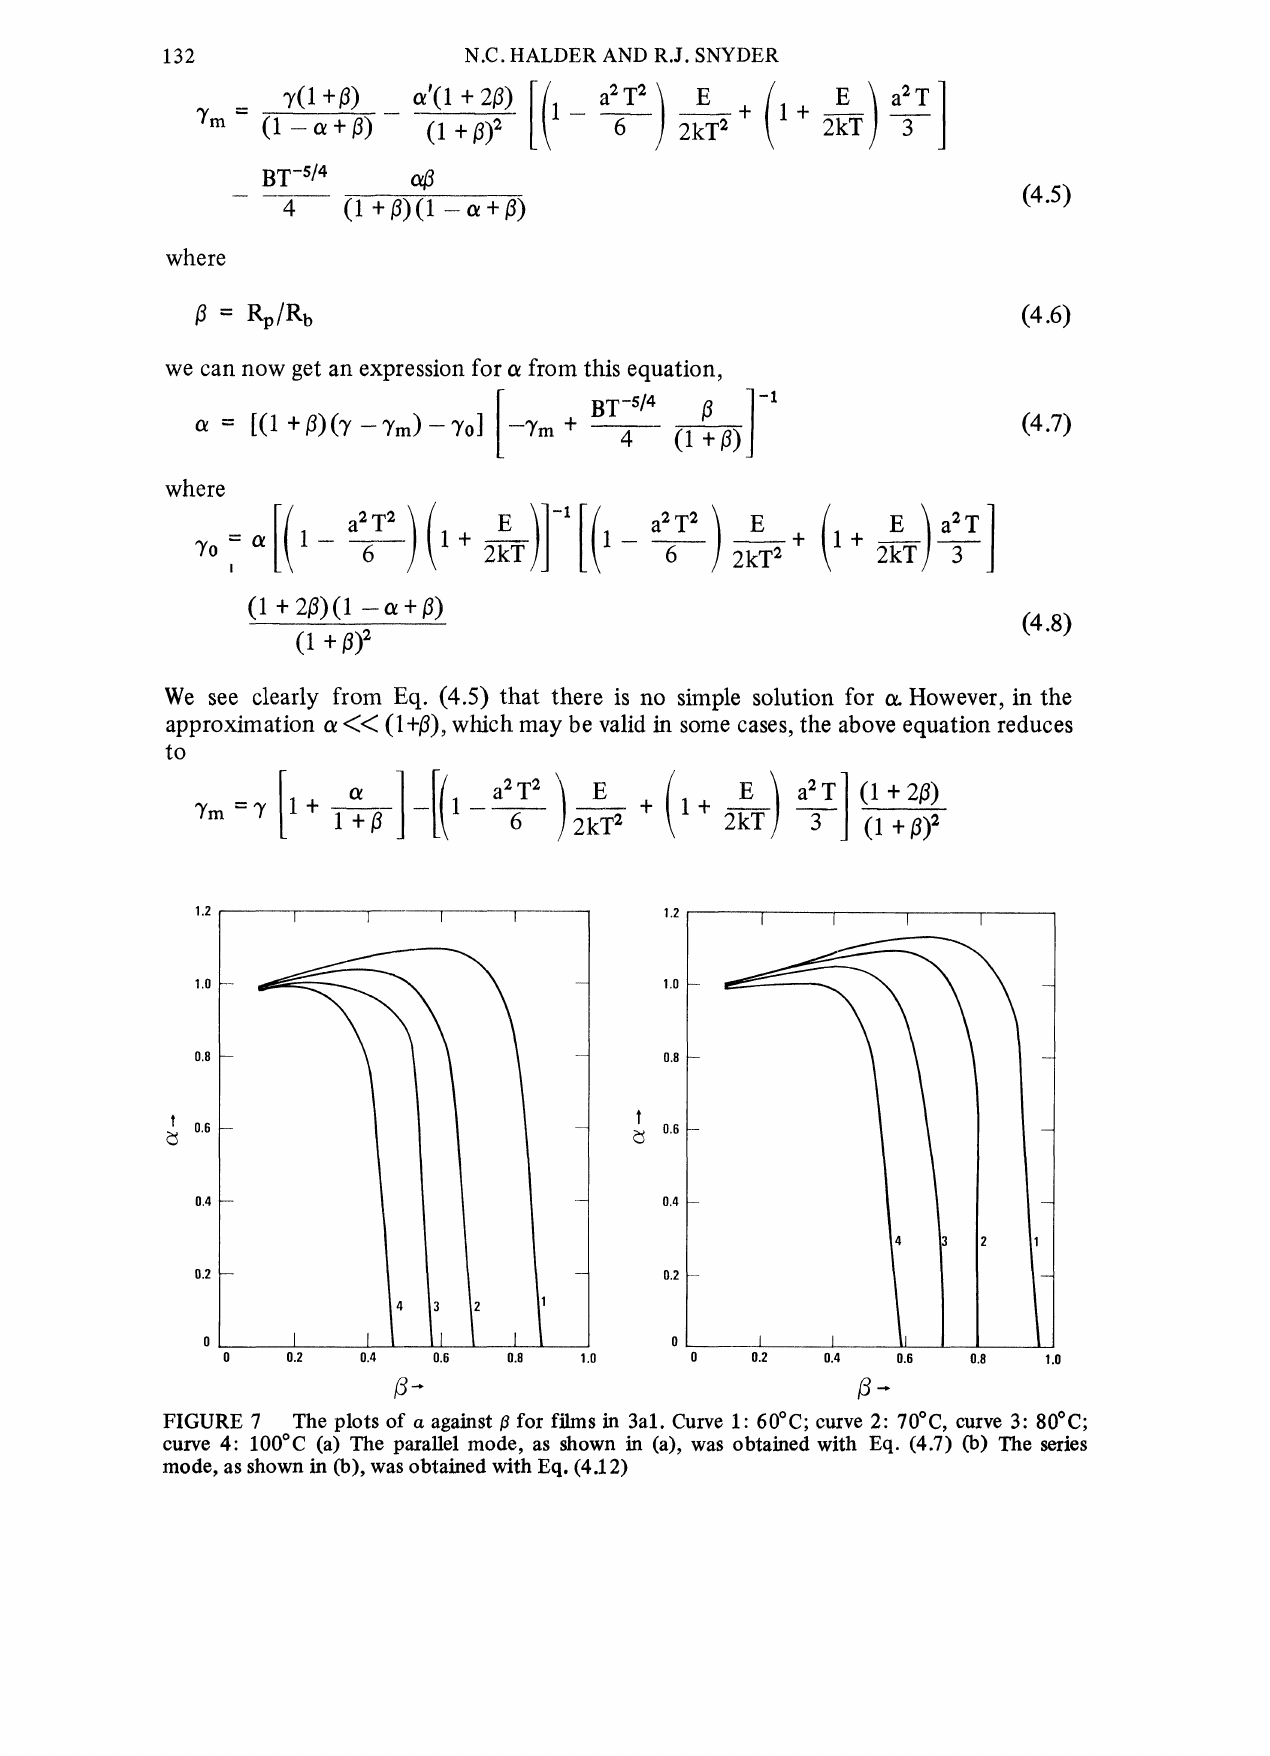
FIGURE 7 The plots of a agast B for fms 3al. Cue 1" 60"C; curve 2" 70C, curve 3" 80"C; cue 4" 100C (a) e pael mode, as shown (a), was obtaed with Eq. (4.7) mode, as shown ), was obtaed th Eq.